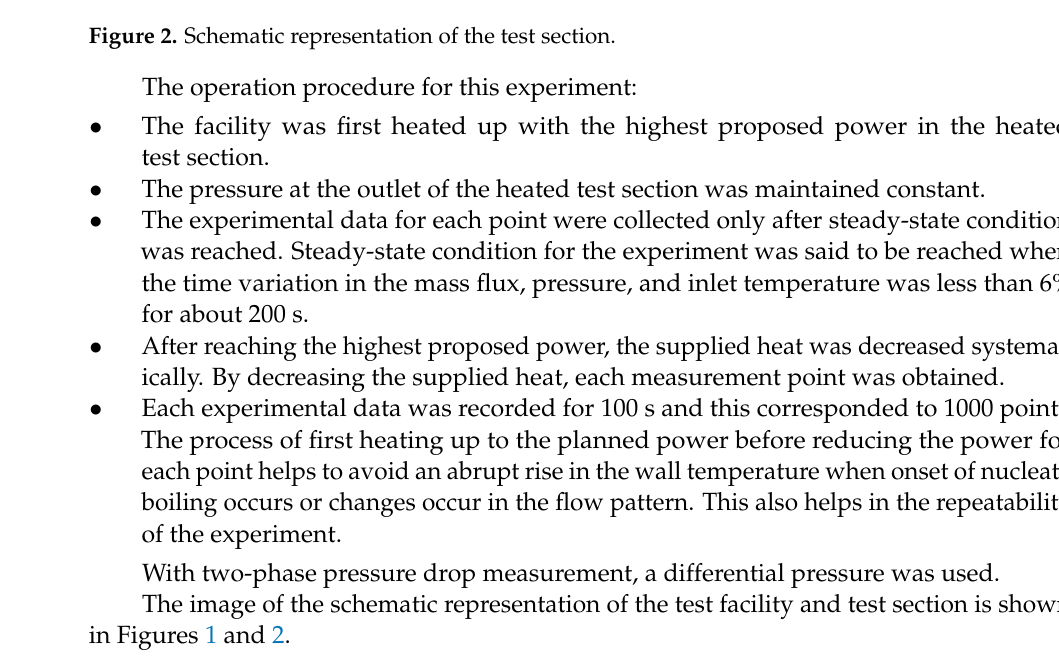
Table 3. Uncertainties of the main operational parameters .